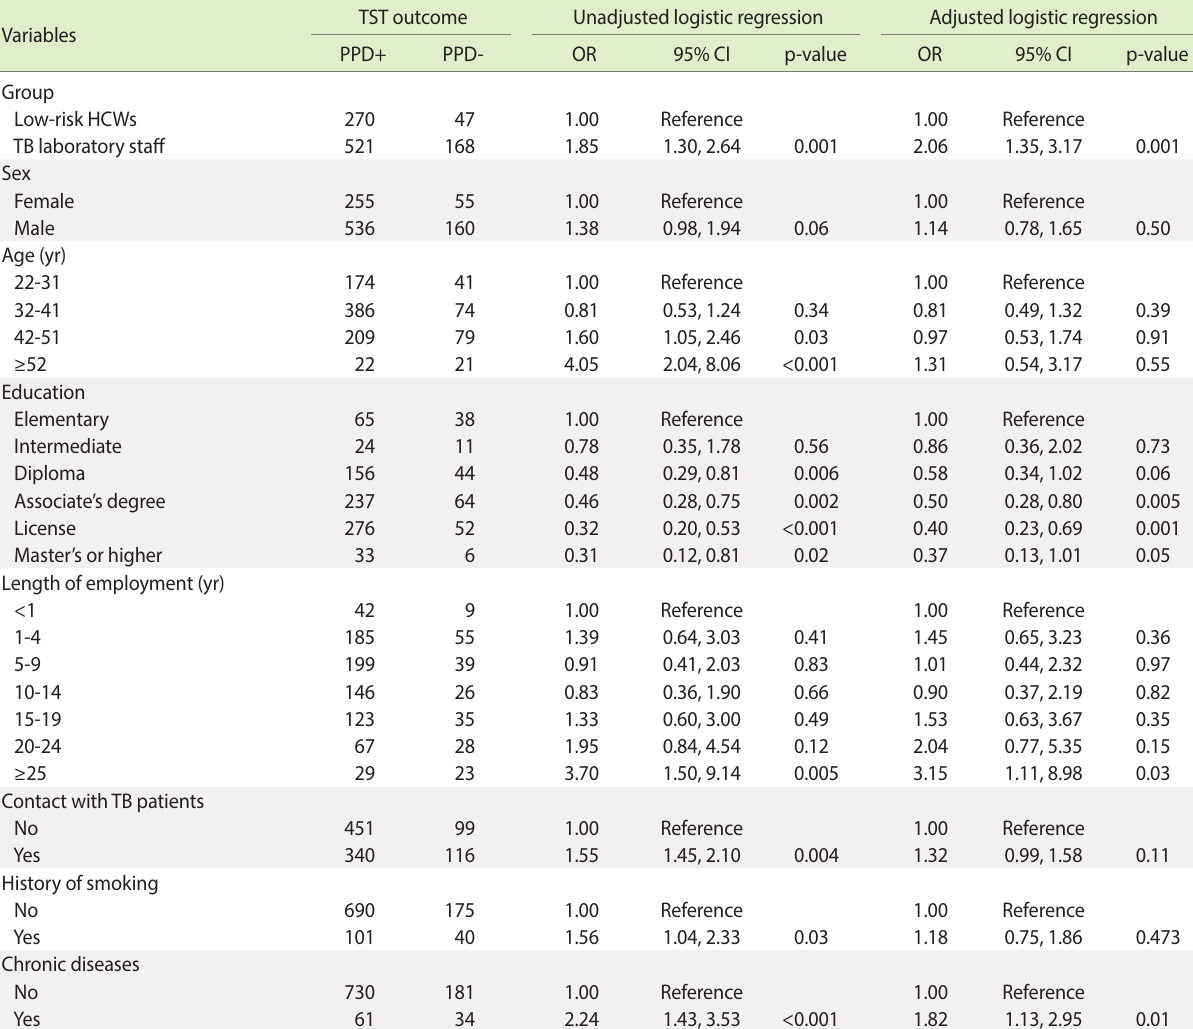
Table 4. Potential risk factors for LTBI based on TST results